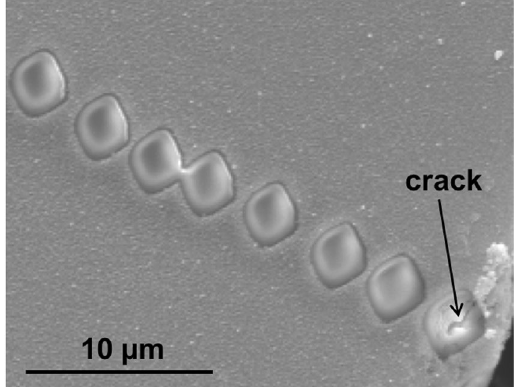
Figure 1. Back-scattered electron image showing NanoSIMS ion beam craters for the [001] profile on olivine PC25 (see Table 1). A crack passing through the first NanoSIMS crater from the crystal edge (bottom-right) was recognized and this analysis was discarded.